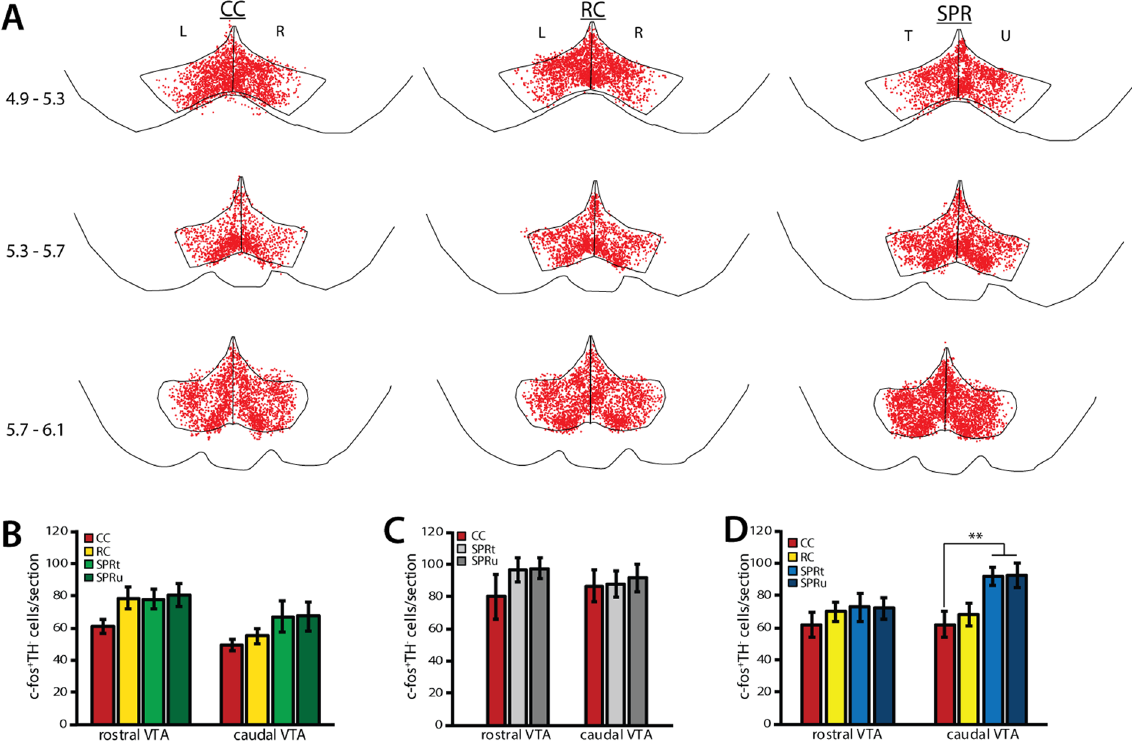
Figure 6. c-fos expression in non-dopaminergic (TH − ) VTA neurons. SPR = single pellet reaching, RC = reward control, CC = cage control. T = trained, U = untrained, L = left, R = right hemisphere. Values are mean ± s.e.m. ( A ) Superposition of TH − c-fos + (red) neurons in VTA derived from 8 animals at plateau (2 sections per position per animal). Numbers indicate position caudal of bregma. ( B ) Numbers of TH − c-fos + neurons in rostral and caudal VTA in SA rats (N = 8). ( C ) Numbers of TH − c-fos + neurons in rostral and caudal VTA in UA rats (N = 6). ( D ) Numbers of TH − c-fos + neurons in rostral and caudal VTA in PL rats. ( ** p < 0.01